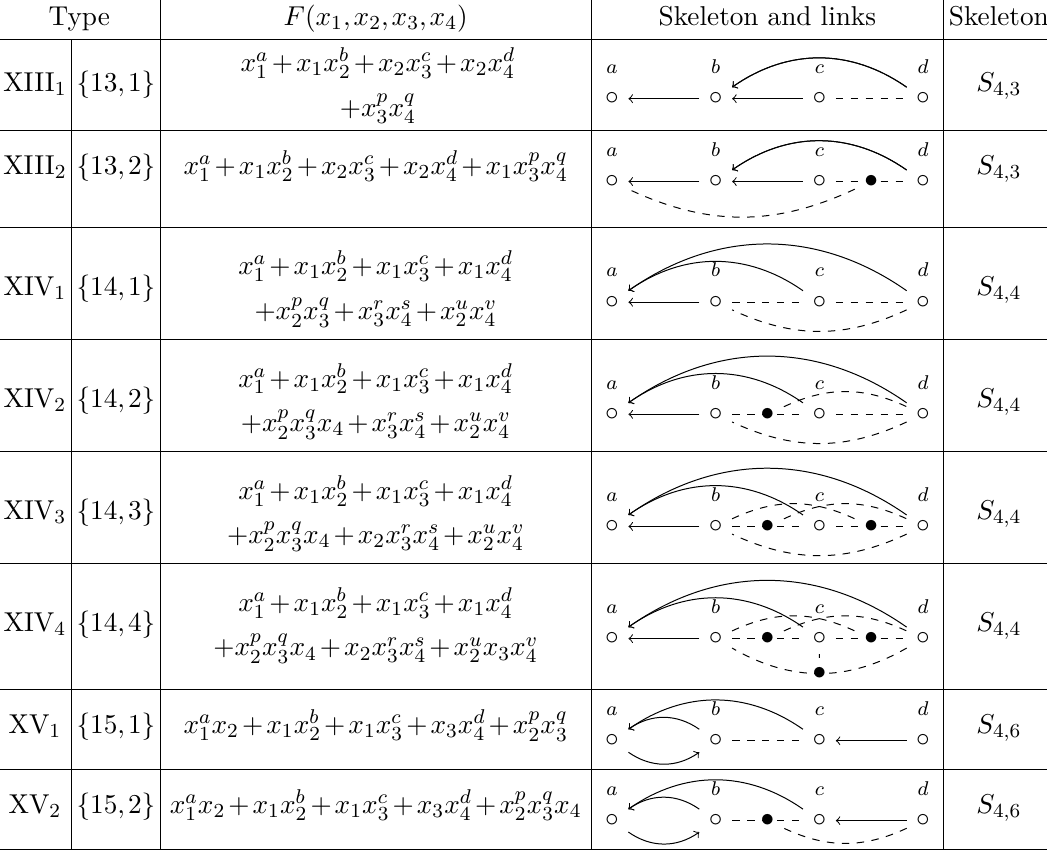
Table 2 . The KS-YY classification of isolated hypersurface singularities in C 4 : types XIII to